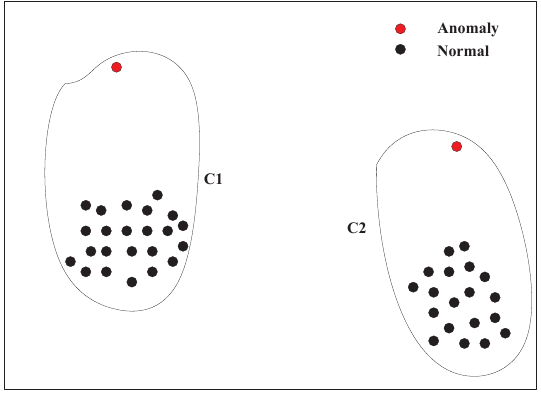
with the help of i . Adapted from [1] i